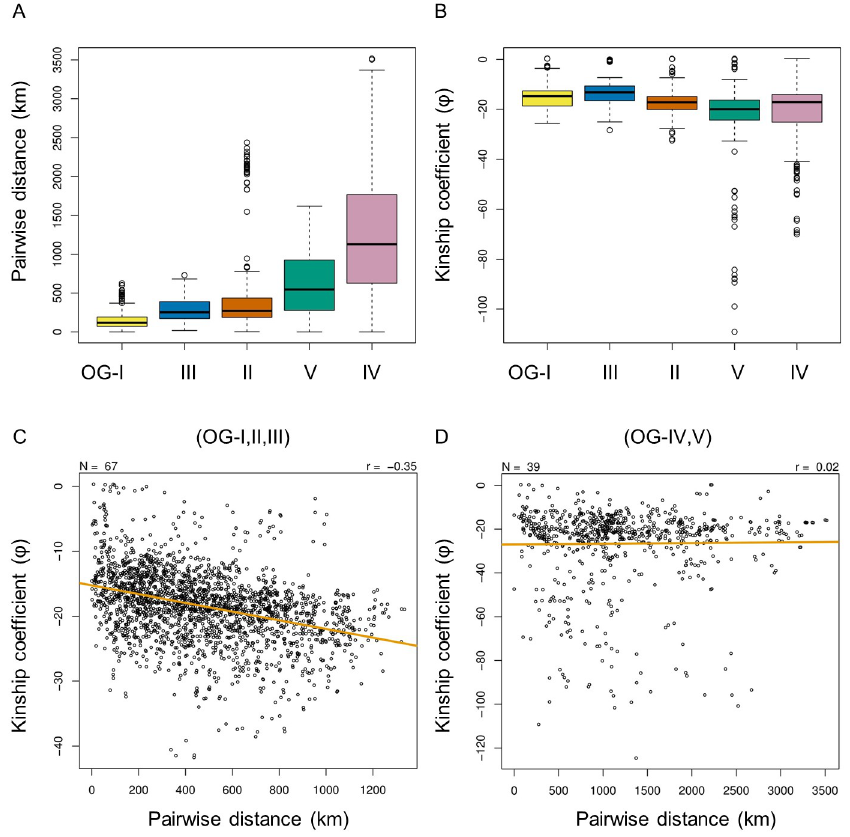
Fig 4. Genetic isolation by distance in O . glaberrima . A. Distribution of the pairwise geographic distances between individuals in kilometres, grouped per population. B. Distribution of the kinship coefficients between individuals, grouped per population. C. Isolation by distance among the coastal populations (OG-I, OG-II and OG-III). Outliers (separated by more than 1500 km) were omitted. D. Isolation by distance among the inland populations (OG-IV and OG-V). Outliers (separated by more than 3500 km) were omitted. Each dot symbolises a unique pair of individuals within in each group. Whereas N denotes the number of accessions included in each analysis, the number of pairwise comparison equals N! and is therefore markedly